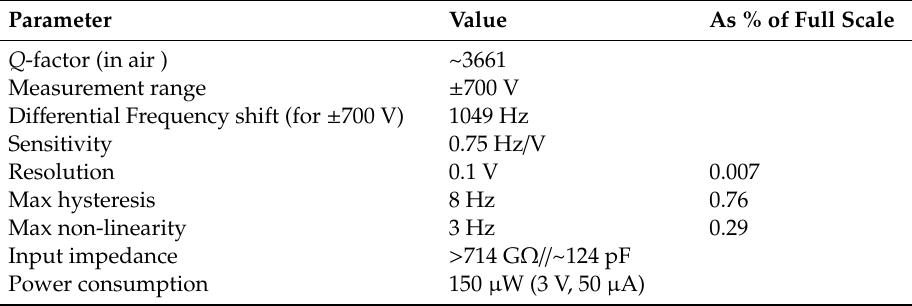
Table 4. Main characteristics of the resonant voltage